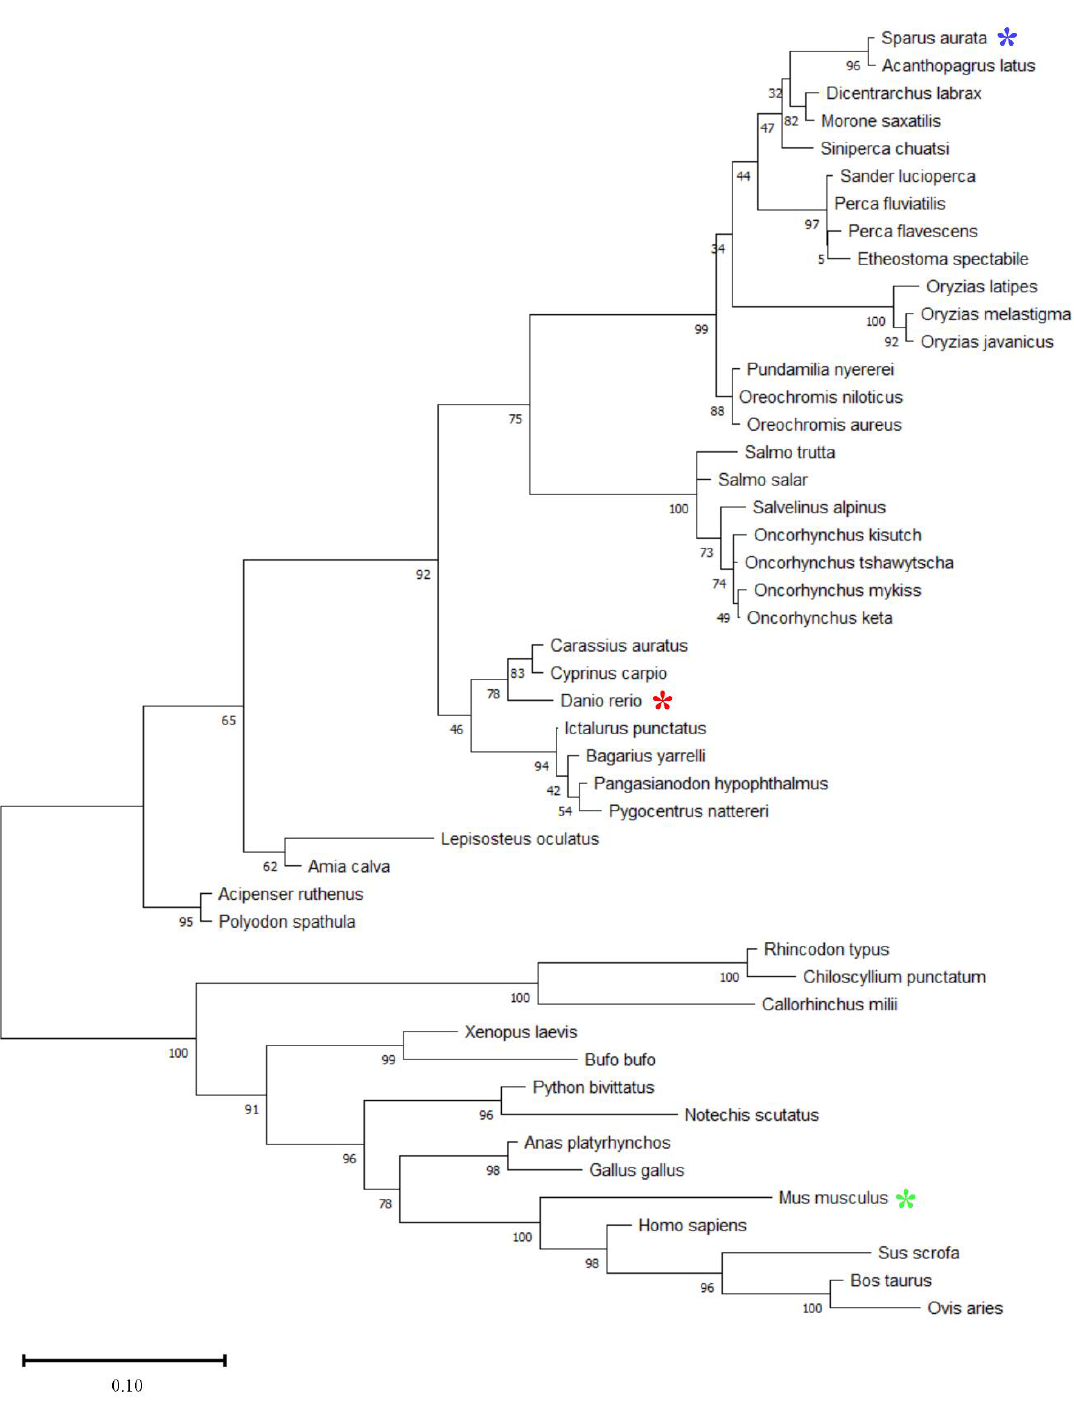
Figure 2. Phylogenetic analysis of Myomaker protein sequences among mammals, birds, reptiles, amphibians, and fish. Multiple alignment of whole protein sequences was done through the MAFFT tool (https://mafft.cbrc.jp/alignment/server/, accessed on 12 February 2020) with the iterative refinement L-INS-i method. The phylogenetic tree was developed with the Maximum Likelihood phylogeny and the JTT+G substitution model using the MEGA 11 v11.0.1.10 program. The numbers in the tree nodes represent the percentage of the bootstrap values after 500 replicates. The study species ( Sparus aurata ), as well as the model species Danio rerio and Mus musculus are marked with blue, red and green